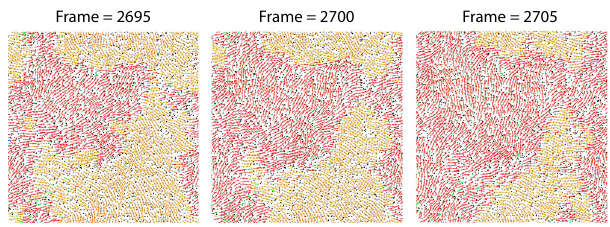
Fig. 8 Visualisation of phase waves. Snapshots from Supplementary movie 4 showing Synchronised Rotation. Here the word phase is used to denote the momentary angle of motion of the particles. At each iteration step, each particle transfers its phase to the neighbouring particles, which leads to a moving wave-like behaviour. The propagation of the phase wave is indicated by the advancing of the region with red colour, denoting angles close to but larger than 0 according to the colour code in